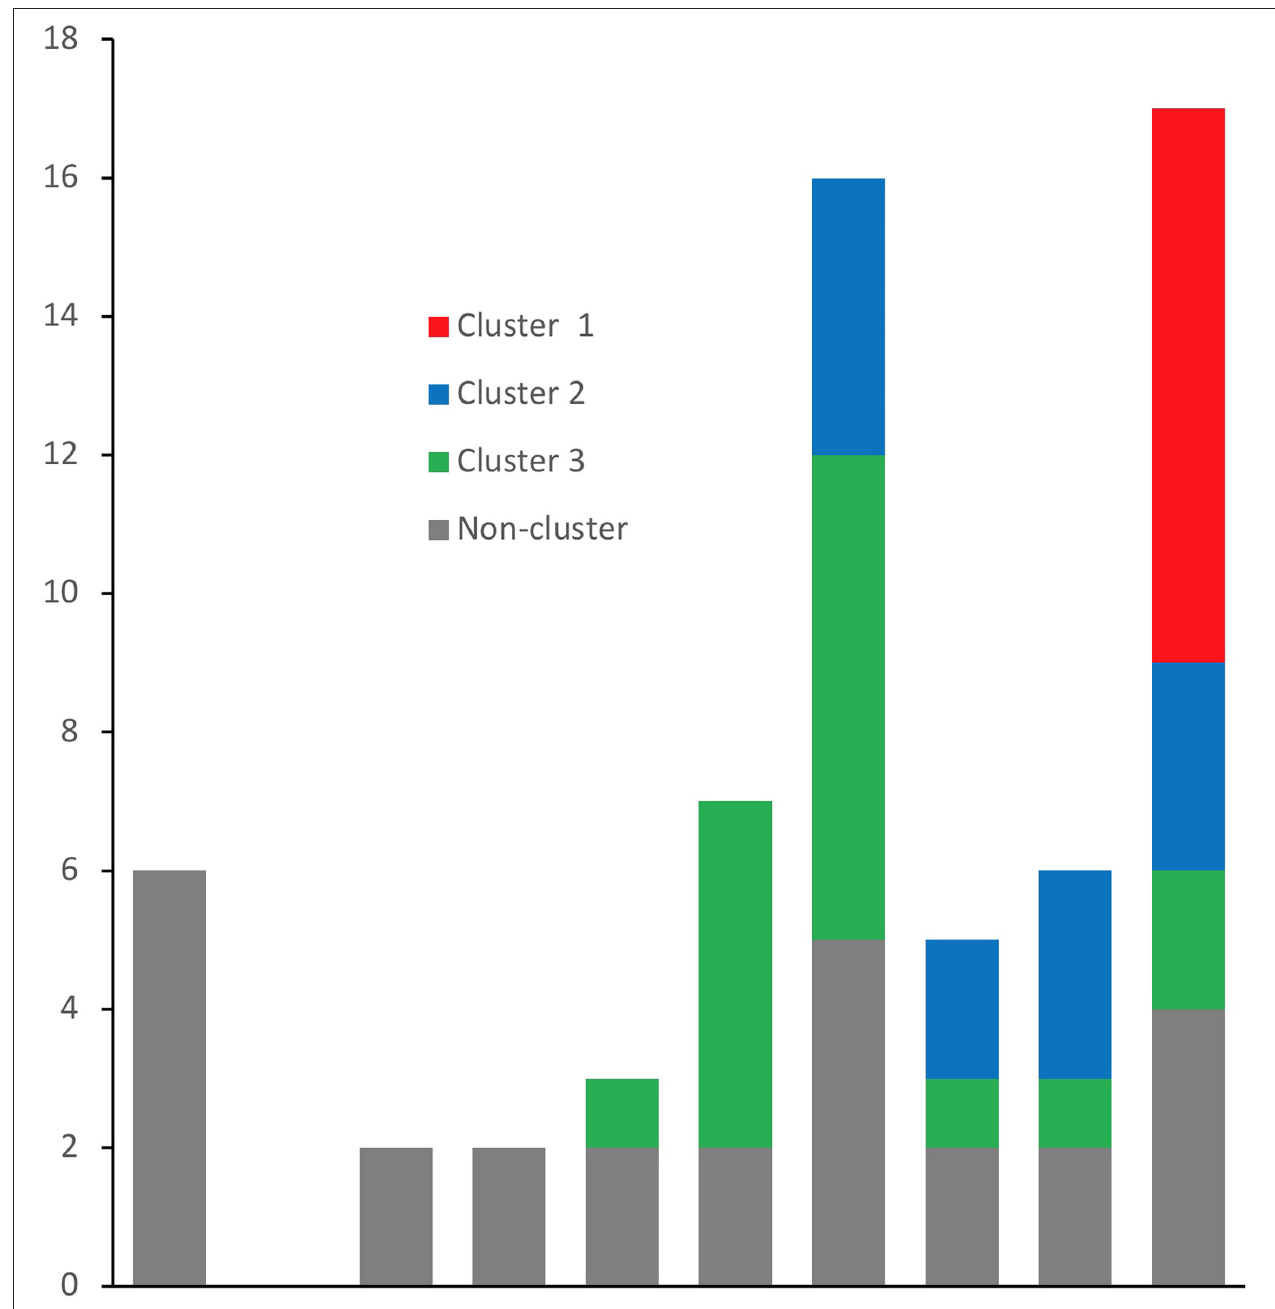
FIGURE 2 | Number of isolates per half a year. Isolates of the three clusters identified from Figure 1 are indicated by color.